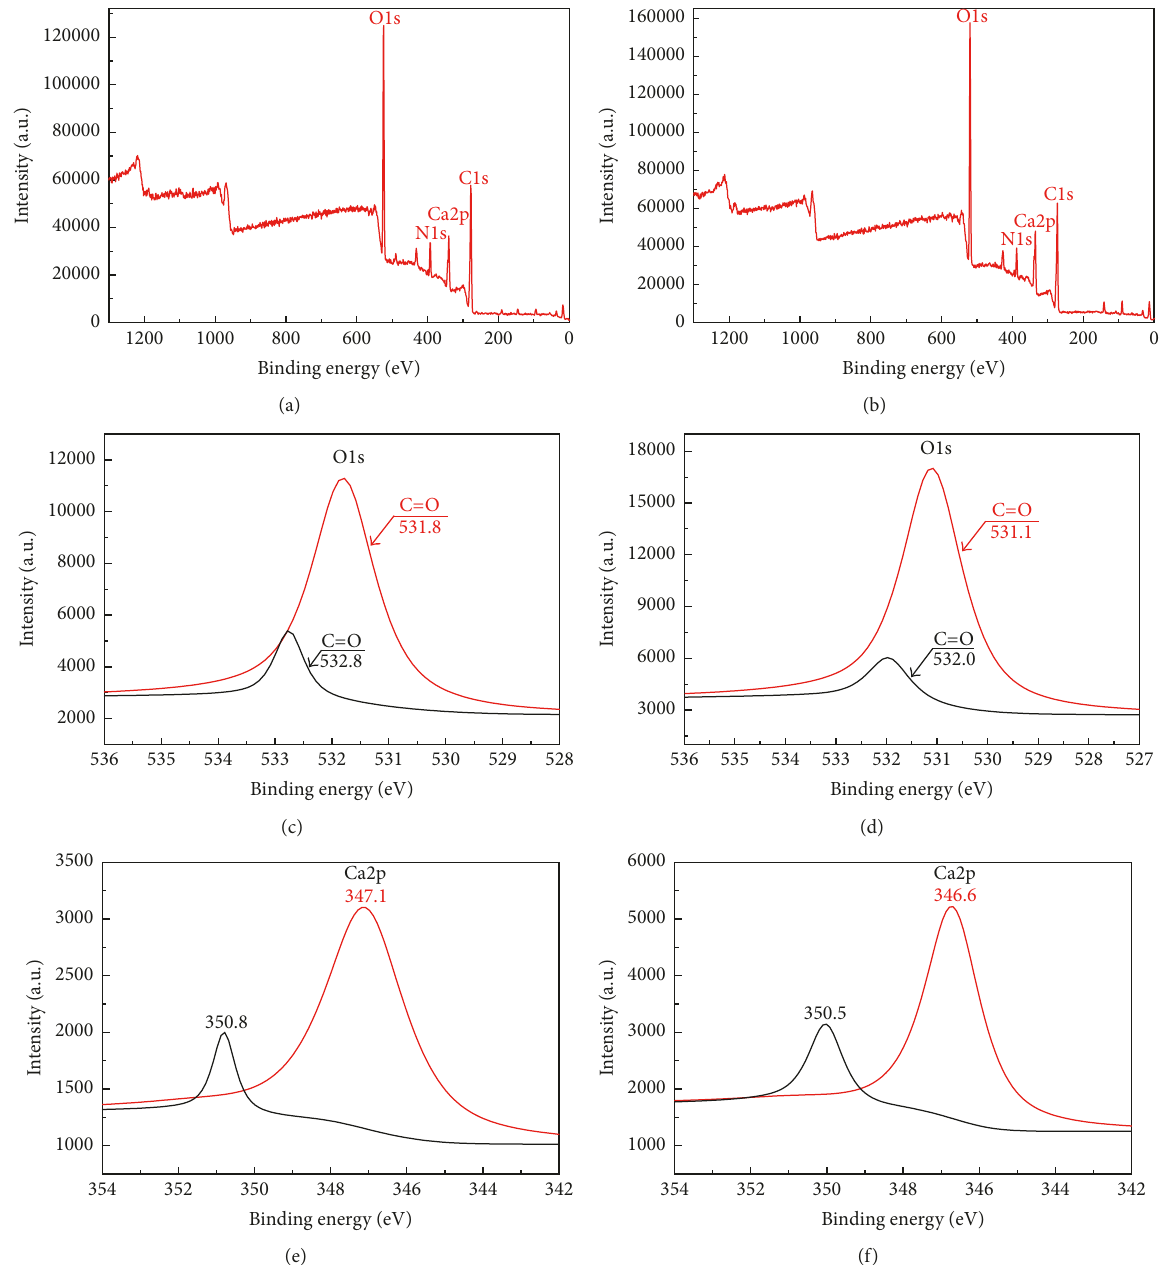
Figure 6: (a) XPS spectrum of mineralized samples without MMT, (b) XPS spectrum of mineralized samples with MMT, (c) XPS spectrum of O1s without MMT, (d) XPS spectrum of O1s with MMT, (e) XPS spectrum of Ca2p without MMT, and (f) XPS spectrum of Ca2p with